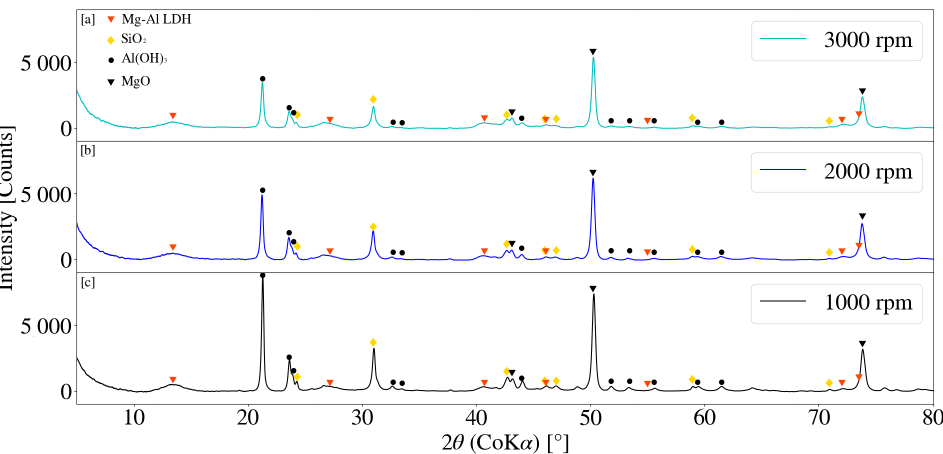
Figure 9. ( a ) X-ray diffraction pattern for Mg-Al LDH sample synthesised for a rotational speed of 3000 rpm (S15). ( b ) X-ray diffraction pattern for Mg-Al LDH sample synthesised for a rotational speed of 2000 rpm (S14). ( c ) X-ray diffraction pattern for Mg-Al LDH sample synthesised for a rotational speed of 1000 rpm (S13). Milling parameters were set at a residence time of 1 h, jacket water inlet temperature of 50 °C, media size of 2 mm and a solids loading of